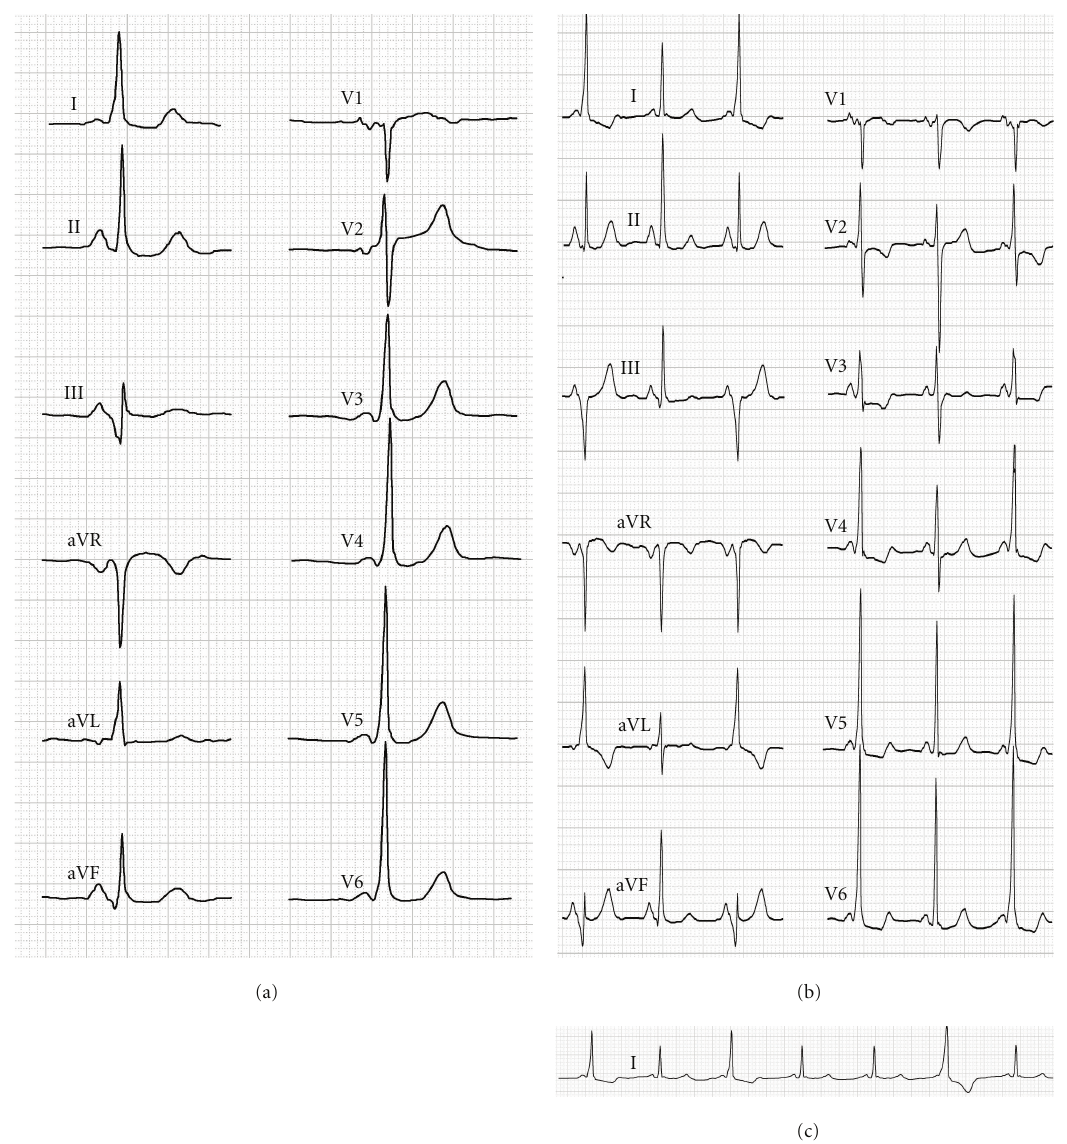
Figure 1: (a) Surface ECGs of the patient. (a) The ECG before the first ablation. A short PR interval, a delta wave. and a widened QRS are clearly seen. Panels (b) and (c) show ECG pattern after the first ablation. (b) Twelve ECG leads show three beats: the first and the third are with the short PR and the wide QRS, while the second beat is normal. (c) The continuous recording of the lead I shows alternation of the PR interval and the